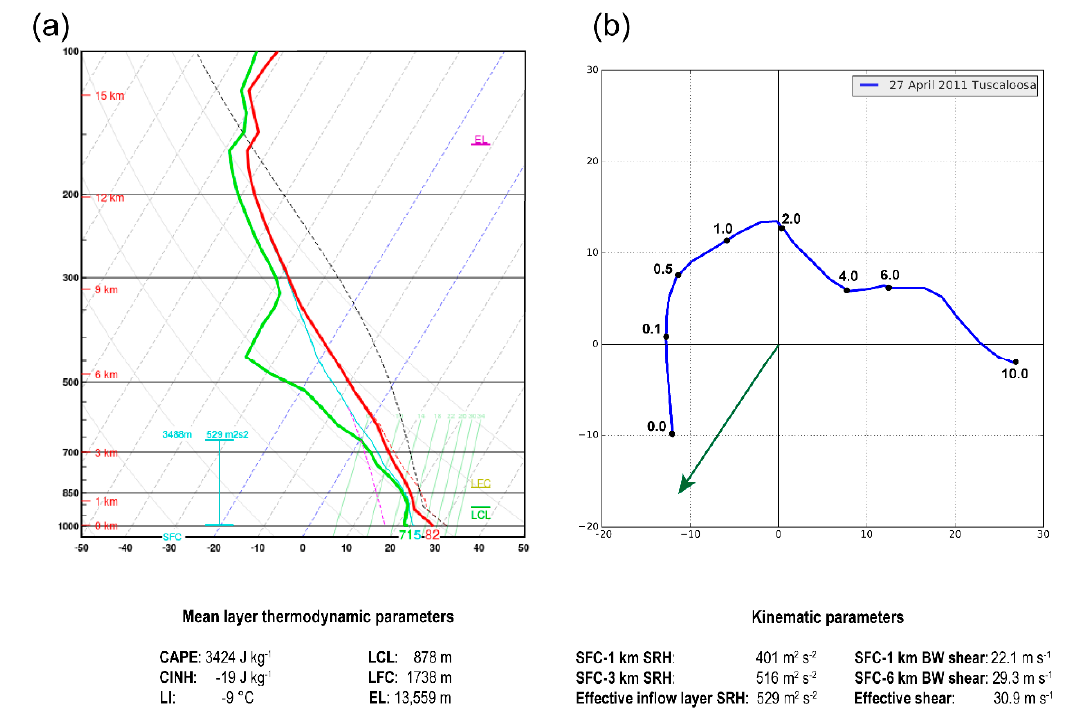
Figure 1. ( a ) Skew T -log p diagram of the thermodynamic profile defining the storm environment. The red and green lines represent the temperature and dew-point temperature profiles, respectively, both in °C. The black dashed line indicates a parcel that ascends pseudo adiabatically from the surface. ( b ) Environmental hodograph of storm-relative winds averaged over a 0.2° × 0.2° latitude-longitude box centered over Tuscaloosa. The green arrow denotes the ground-relative storm motion vector that has been subtracted from the wind profile. Some relevant convective parameters are shown below the figures. The sounding and convective parameters were produced using the Sounding and Hodograph Analysis and Research Program in Python (SHARPpy) software [29].